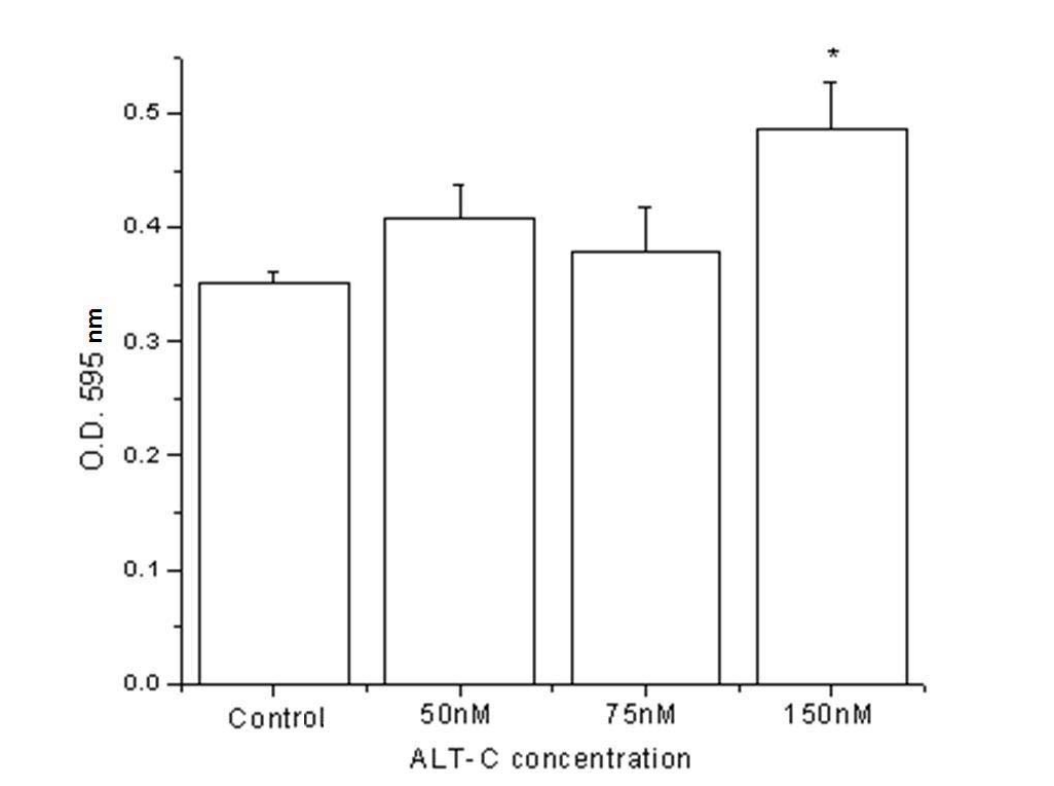
Figure 2. Viability of myoblasts in absence (control) and presence of ALT-C at different concentrations 48 hours after incubation in collagen I-coated wells (*p ≤ 0.05;